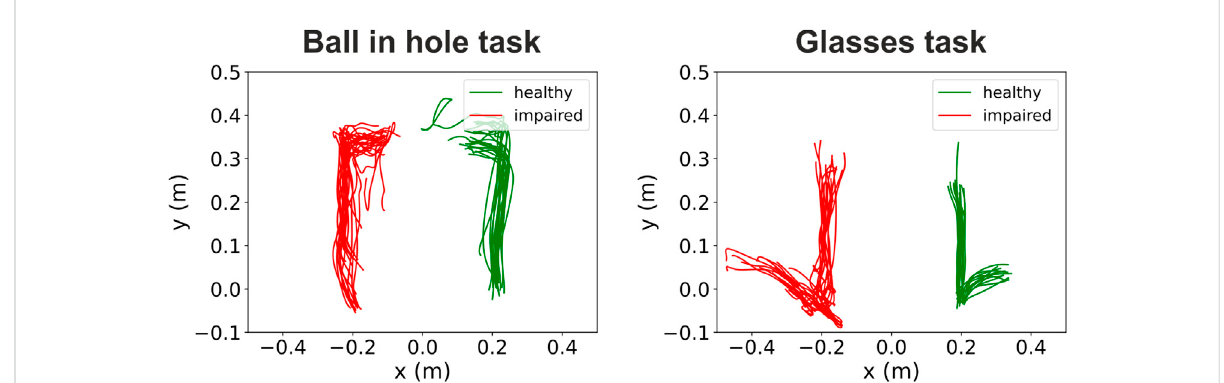
FIGURE 5 Exampleofhandtrajectoriesrecordedduringtaskexecution.Thetwopanelsshowthehandtrajectoriesofa77-yearoldmalepatientduringthe execution of the “ ball in hole ” (left panel) and “ glasses ” (right panel) tasks. This patient exhibited a left side impairment. The trajectories of the healthy and impaired hands are shown in green and red